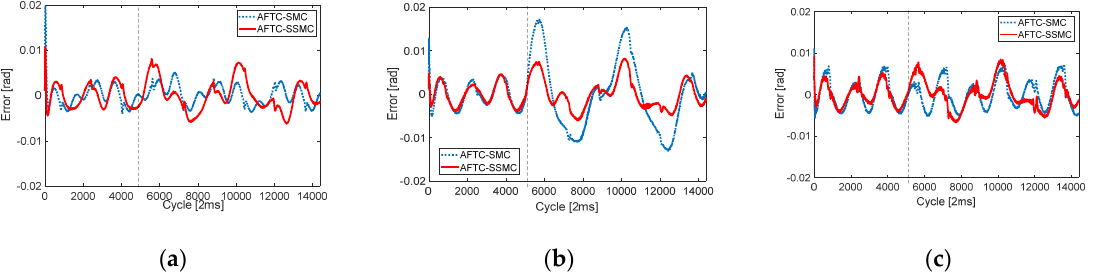
Figure 11. Tracking error at each joint with a single joint fault occurring at Joint 2. ( a ) Joint 1; ( b ) Joint 2; ( c ) Joint